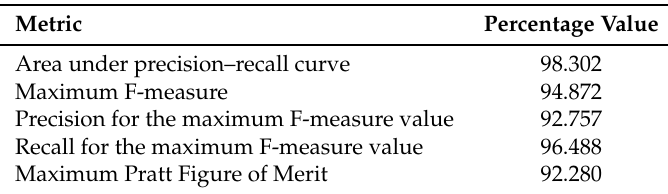
Table 6. Area under mean precision–recall curve, maximum mean F-measures, precision and recall for the F-measure presented, and maximum mean Pratt Figure of Merit for the H&E-stained tissue images mosaics. The values are expressed as percentage values.